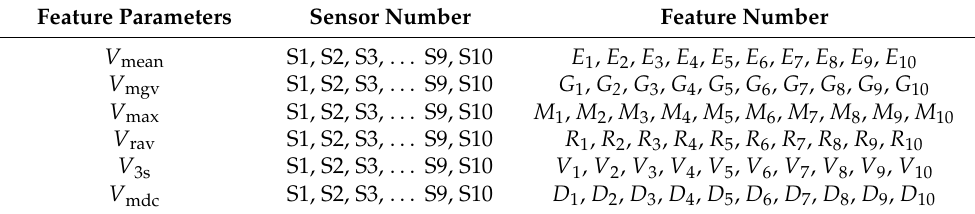
Table 2. The correspondence between each feature and feature